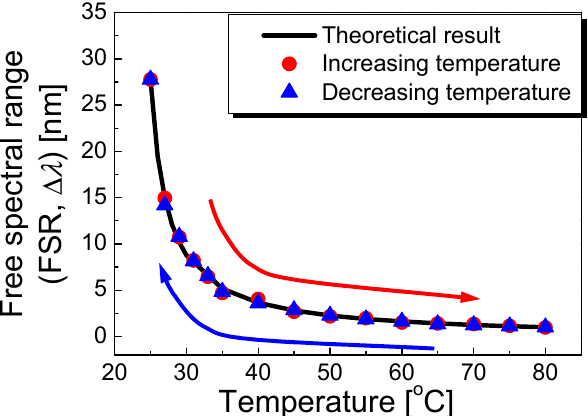
Figure 4. Theoretical (black line) and experimental results (red circles and blue triangles) on the FSR variation in the polymer-overlaid microfiber MZI as a function of temperature.